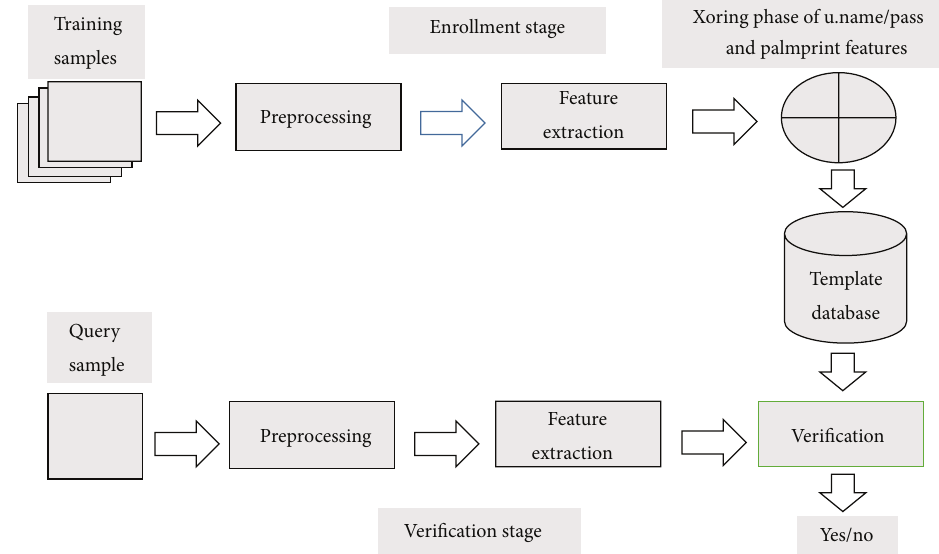
Figure 2: Enrollment and verification stage of the proposed system.